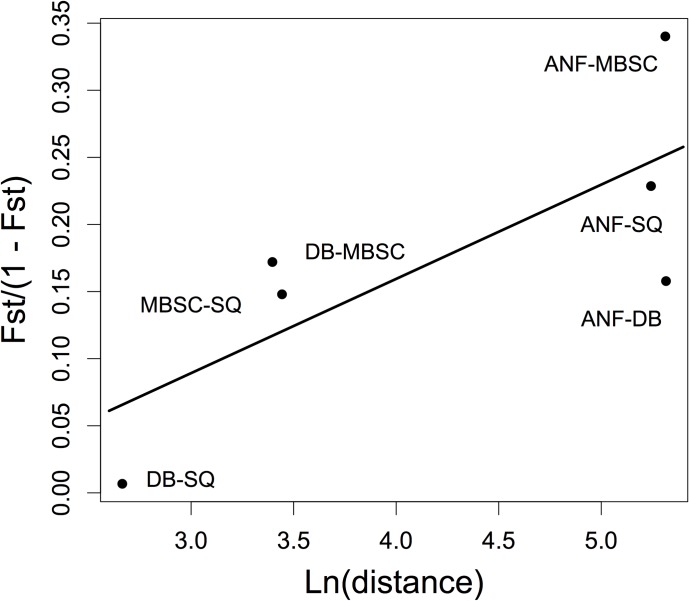
Relationship between geographic distance and genetic differentiation.Regressing linearized FST values against the natural logarithm of distance (km) revealed a positive relationship indicative of IBD among sites within the OH/PA cluster.